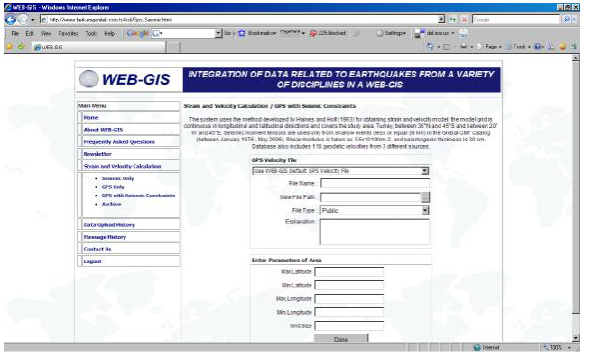
Figure 3. Web interface